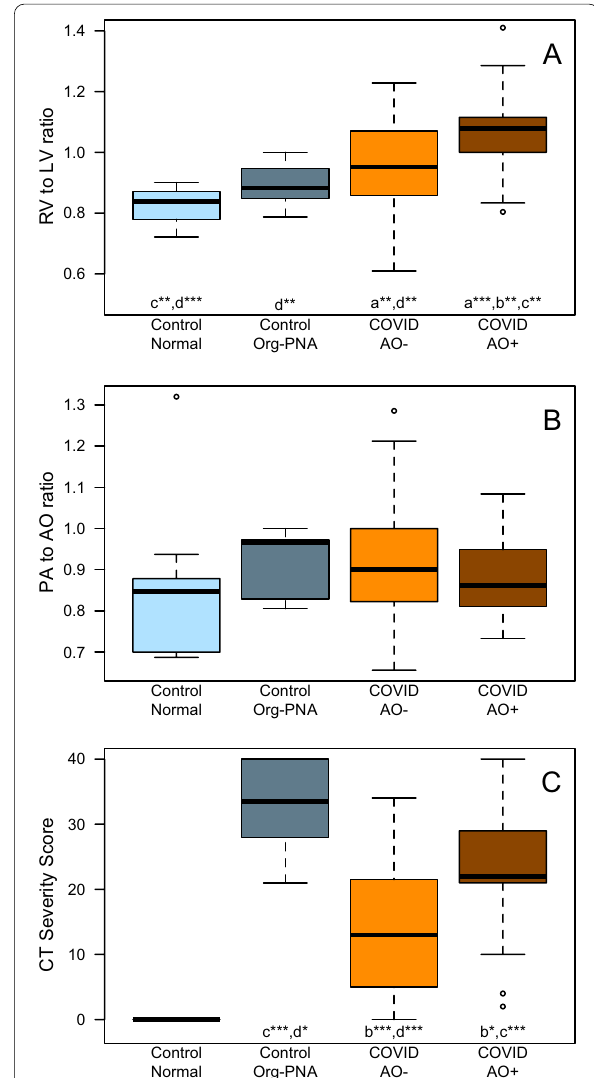
Fig. 3 Comparison of RV:LV ratio, PA:AO ratio, and CT severity score between control and COVID-19 groups. Box and Whisker plots comparing A the ratio of RV to LV dimensions, B the ratio of PA to AO dimensions, and C the CT severity score (CT-SS). Horizontal lines represent median, boxes first and third quartile, whiskers 95%. Groups: control normal (control group without pneumonia); control Org-PNA (control group with organizing pneumonia); COVID-AO − (COVID-19 without adverse outcomes); COVID-AO (COVID-19 with + adverse outcomes: death, or intubation, or ICU admission). Results of post-hoc pairwise comparison shown by letters (a, b, c, d for Control Normal, Control Org-PNA, COVID-AO , COVID-AO , respectively); − + significance level (adjusted for multiple testing using